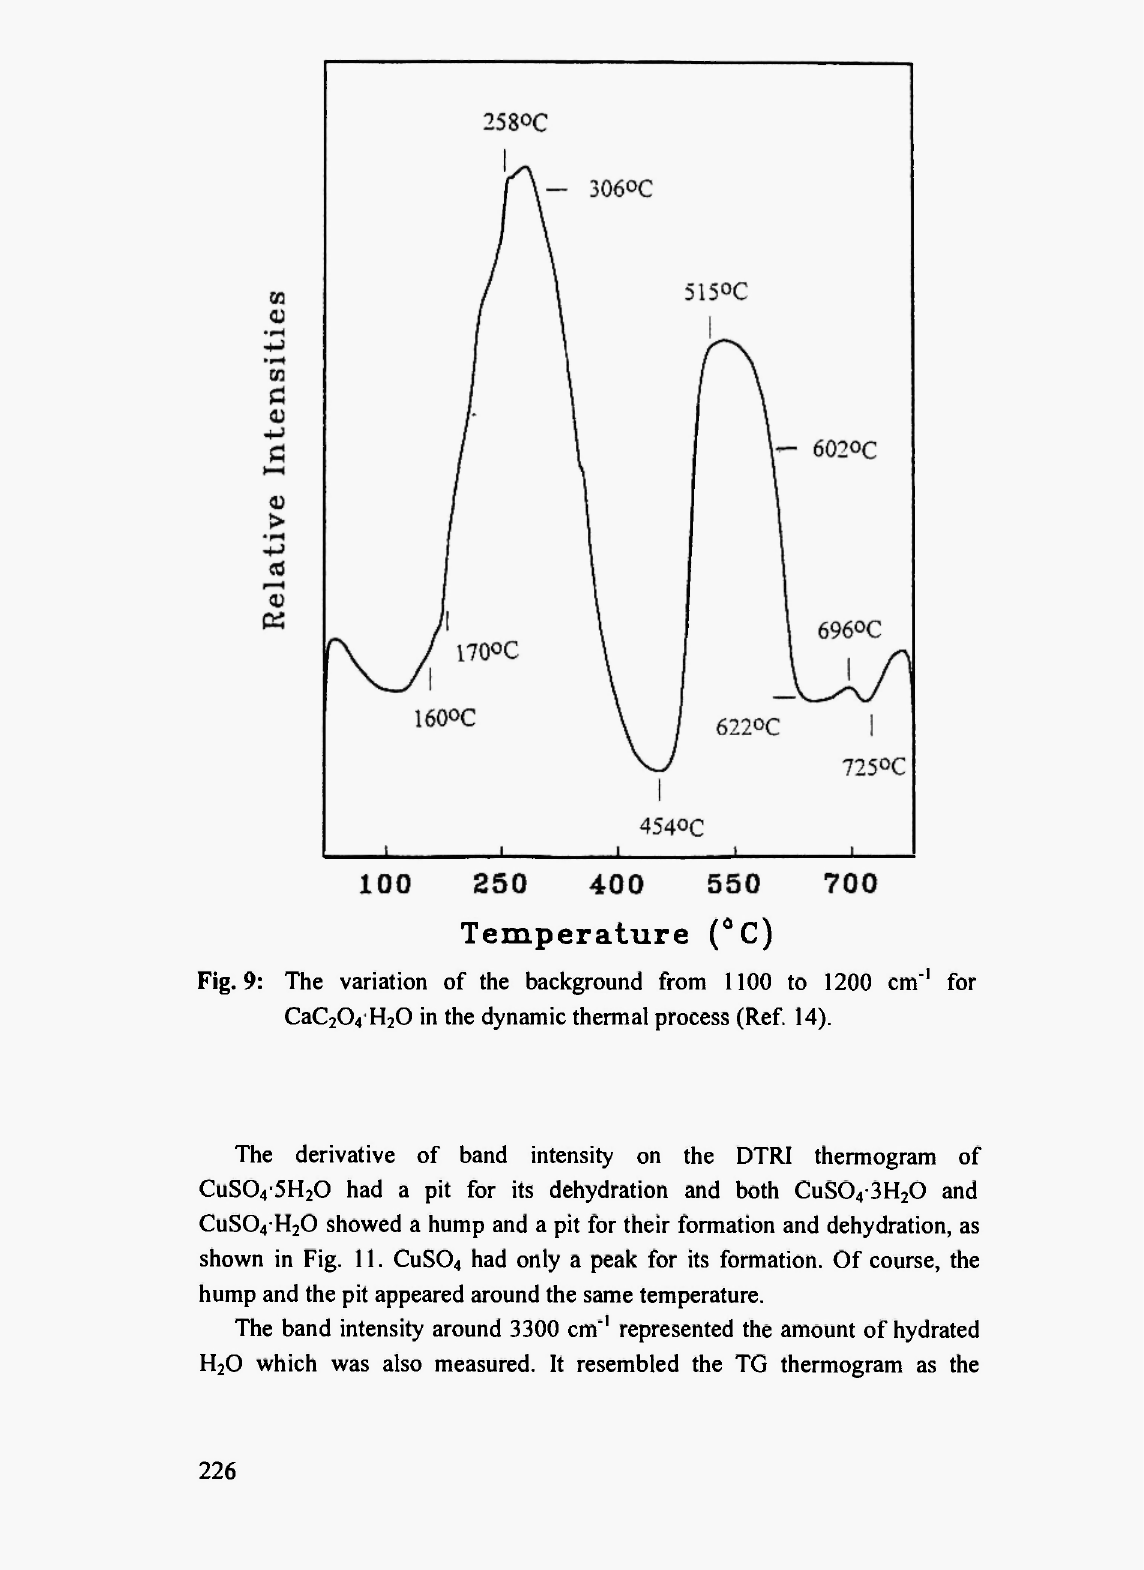
Fig. 9: The variation of the background from 1100 to 1200 cm" 1 for CaC 2 0 4 H 2 0 in the dynamic thermal process (Ref. 14).